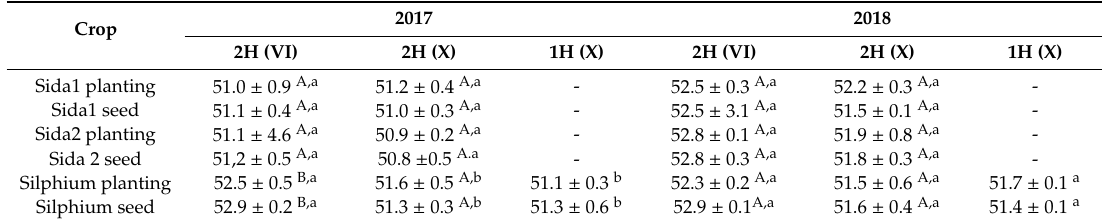
Table 3. Mean values of biomethane content in specific biogas yield (SBY) of the analysed crops biomass,